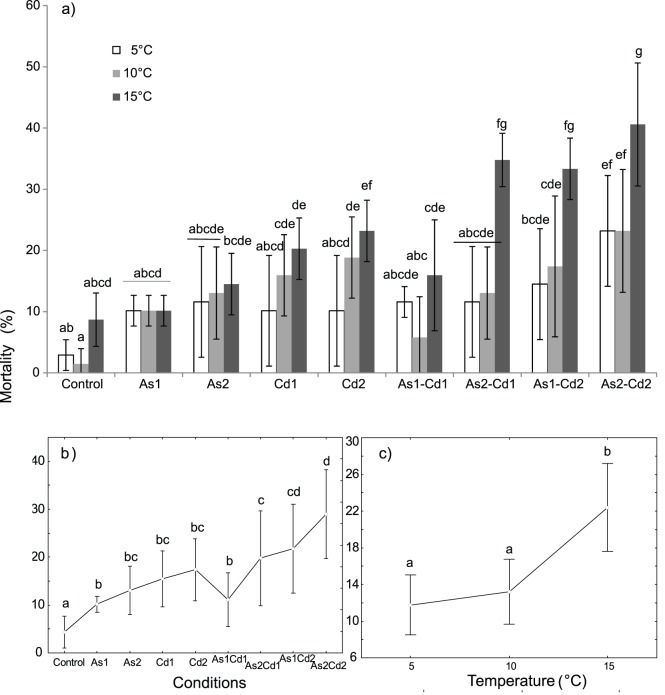
Mean mortality (%) in Gammarus pulex exposed to different conditions at three temperatures (5-10-15°C).The different conditions were “control”, “arsenate”, “cadmium” and four binary mixtures. a) Temperature × condition effect: Mean mortality for each tested condition and temperature. Vertical bars represent standard deviations. b) Condition effect: Weighted mean mortality for each tested condition (results for all the tested temperatures were combined). Vertical bars represent 0.95 confidence intervals. c) Temperature effect: Weighted mean mortality for each temperature (results for all the tested conditions were combined). Vertical bars represent 0.95 confidence intervals. Letters (a to g) were used as labels to illustrate significant differences in mean mortality values (two-way ANOVAs + LSD Fisher post hoc tests; at p<0.05 level of significance).